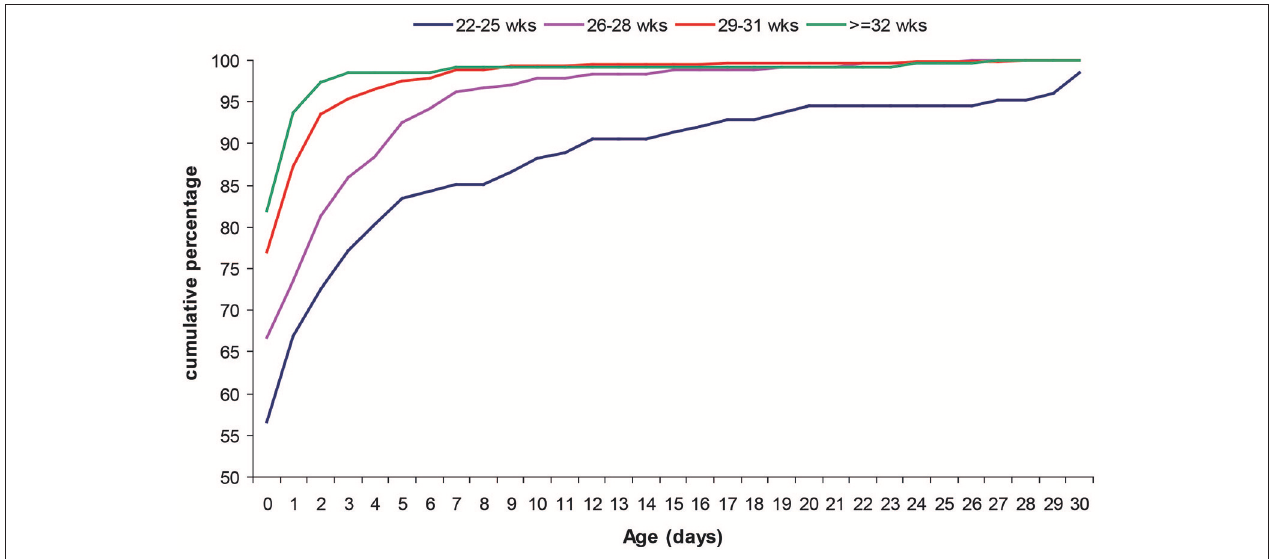
FIGURE 2 | Postnatal age at the beginning of enteral feeding by GA classes.